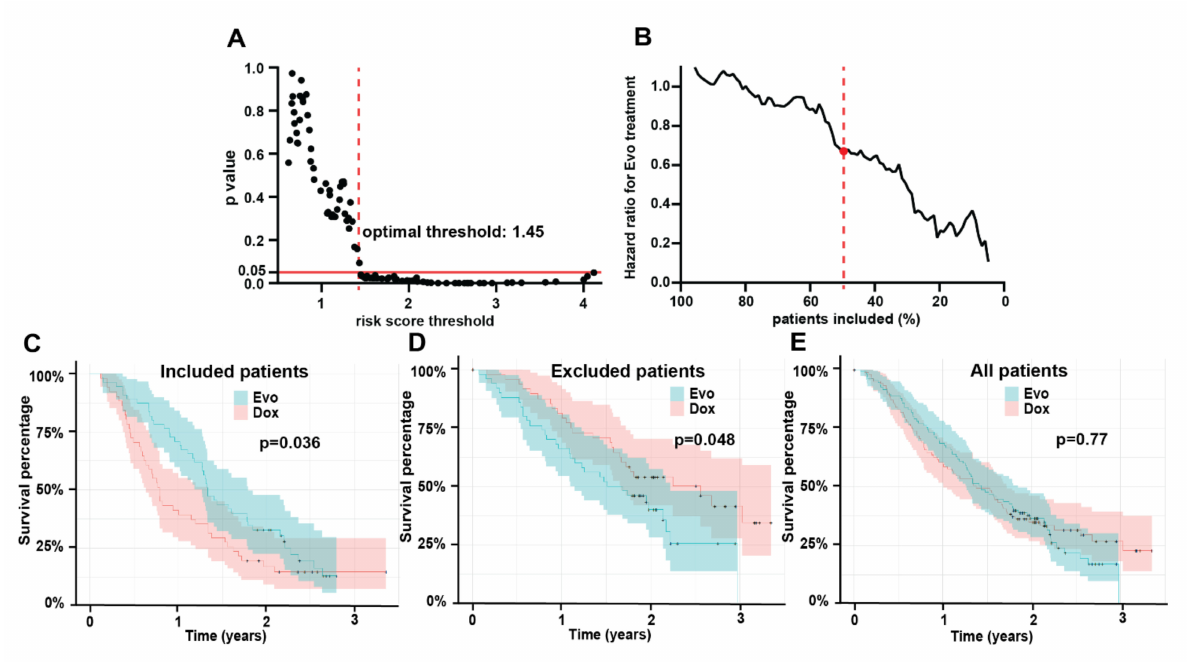
Figure 2. Multivariable Cox model enables selection of patients who benefit from Evofosfamide + Dox- orubicin in training cohort. Quantification of the p value of overall survival difference in the training cohort between the Evofosfamide + Doxorubicin (Dox + Evo) vs. Doxorubicin alone (Dox)